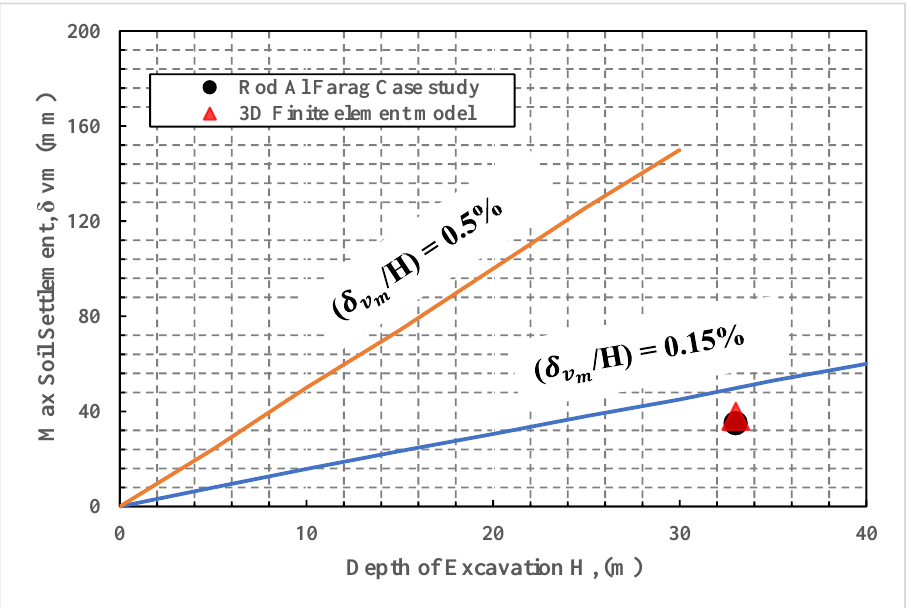
Figure 15. Allocation of the obtained ratio of the maximum measured vertical soil settlement to the excavation depth of the Rod El Farag case study on the Clough and O’Rourke chart [14].